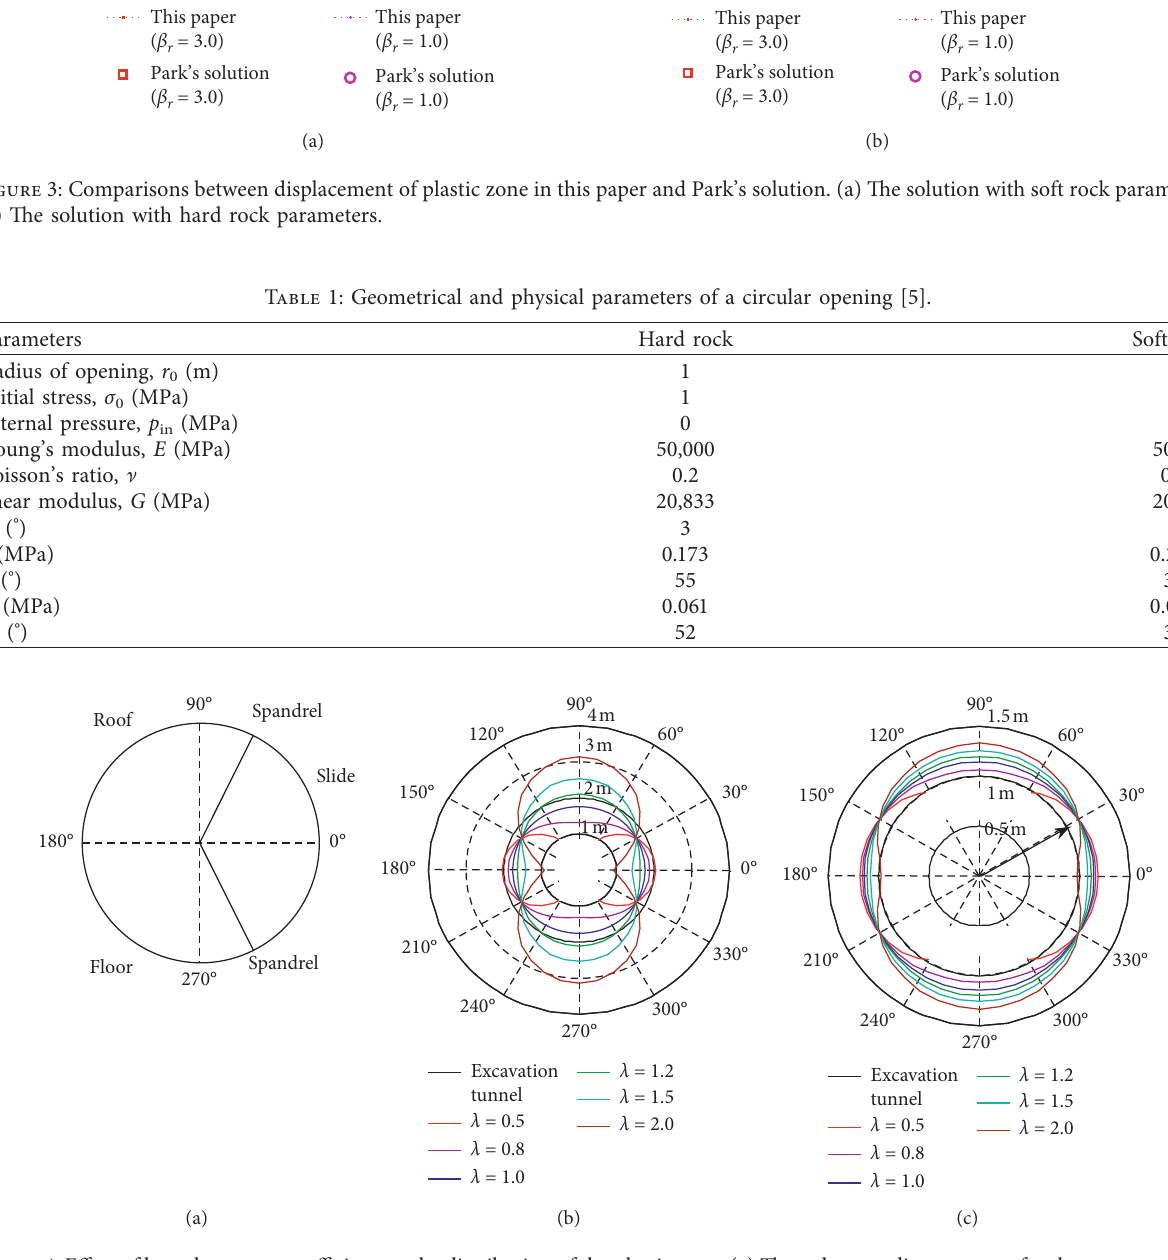
Figure 4: Effect of lateral pressure coefficient on the distribution of the plastic zone. (a) The polar coordinate system for the postprocessing of the results. (b) The result with soft rock parameters. (c) The result with hard rock